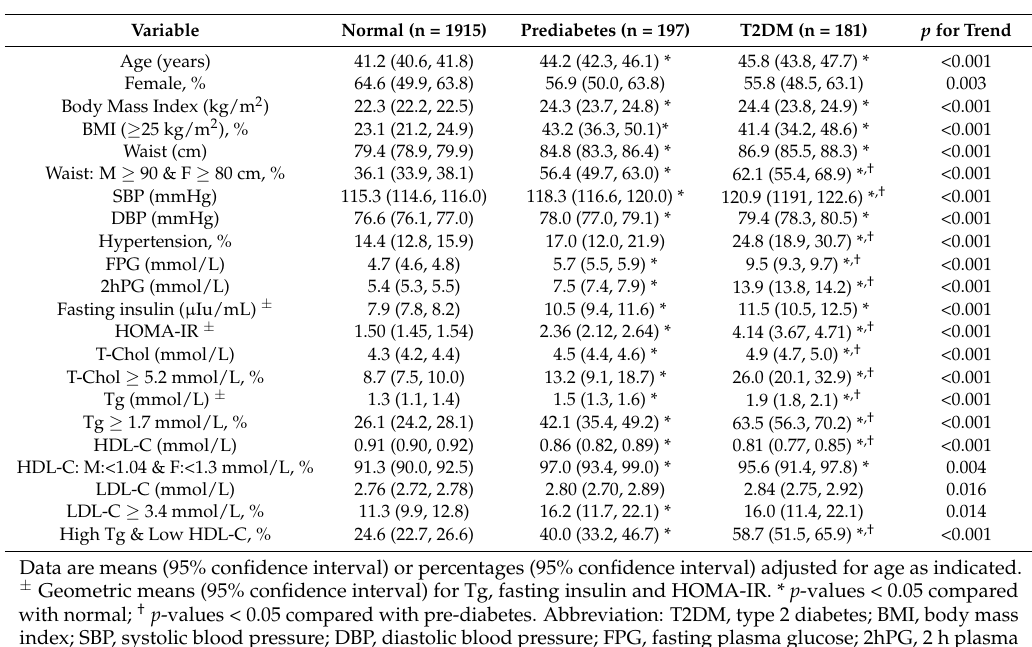
Table 1. Characteristics of the study participants by the level of glucose intolerance.